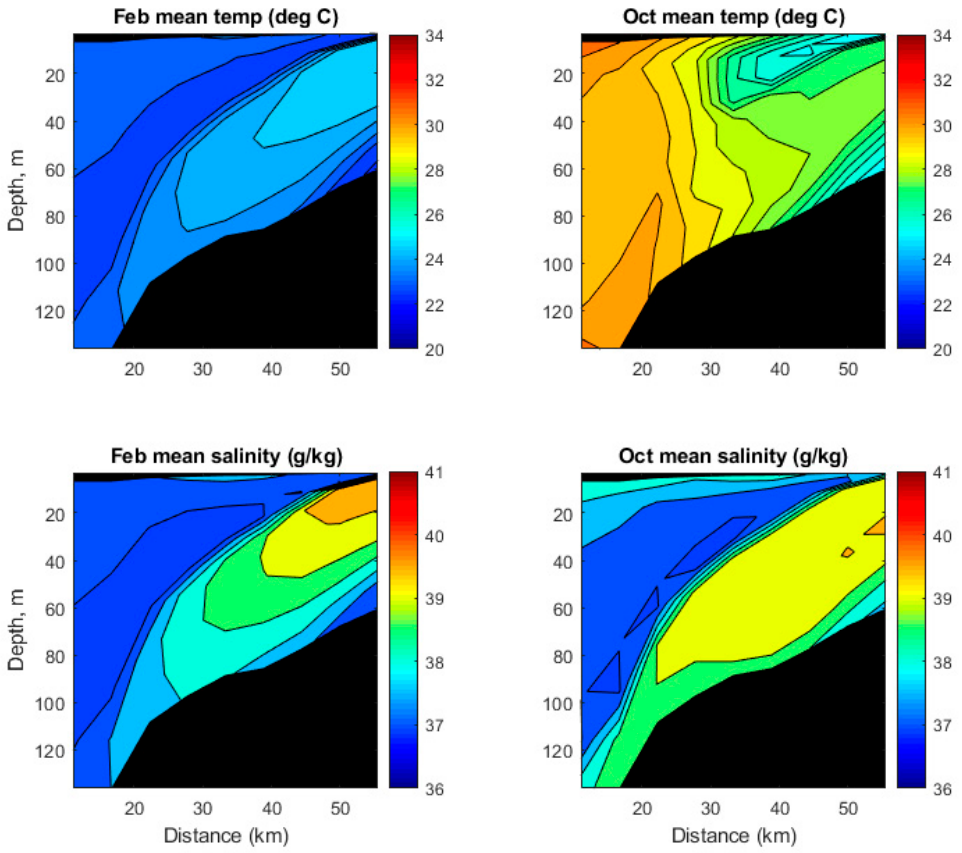
Figure 9. Cross sections of (top) temperature, (bottom) salinity, using the current Delft3D model, for the months of February and October. Distances are from south to north along the Hormuz Strait.